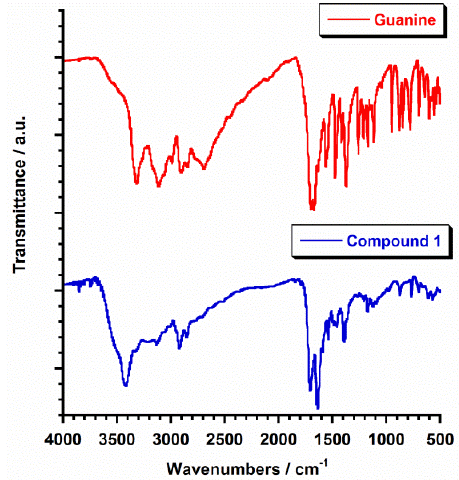
Figure 2. FT-IR spectra for guanine (red) and compound 1 (blue).